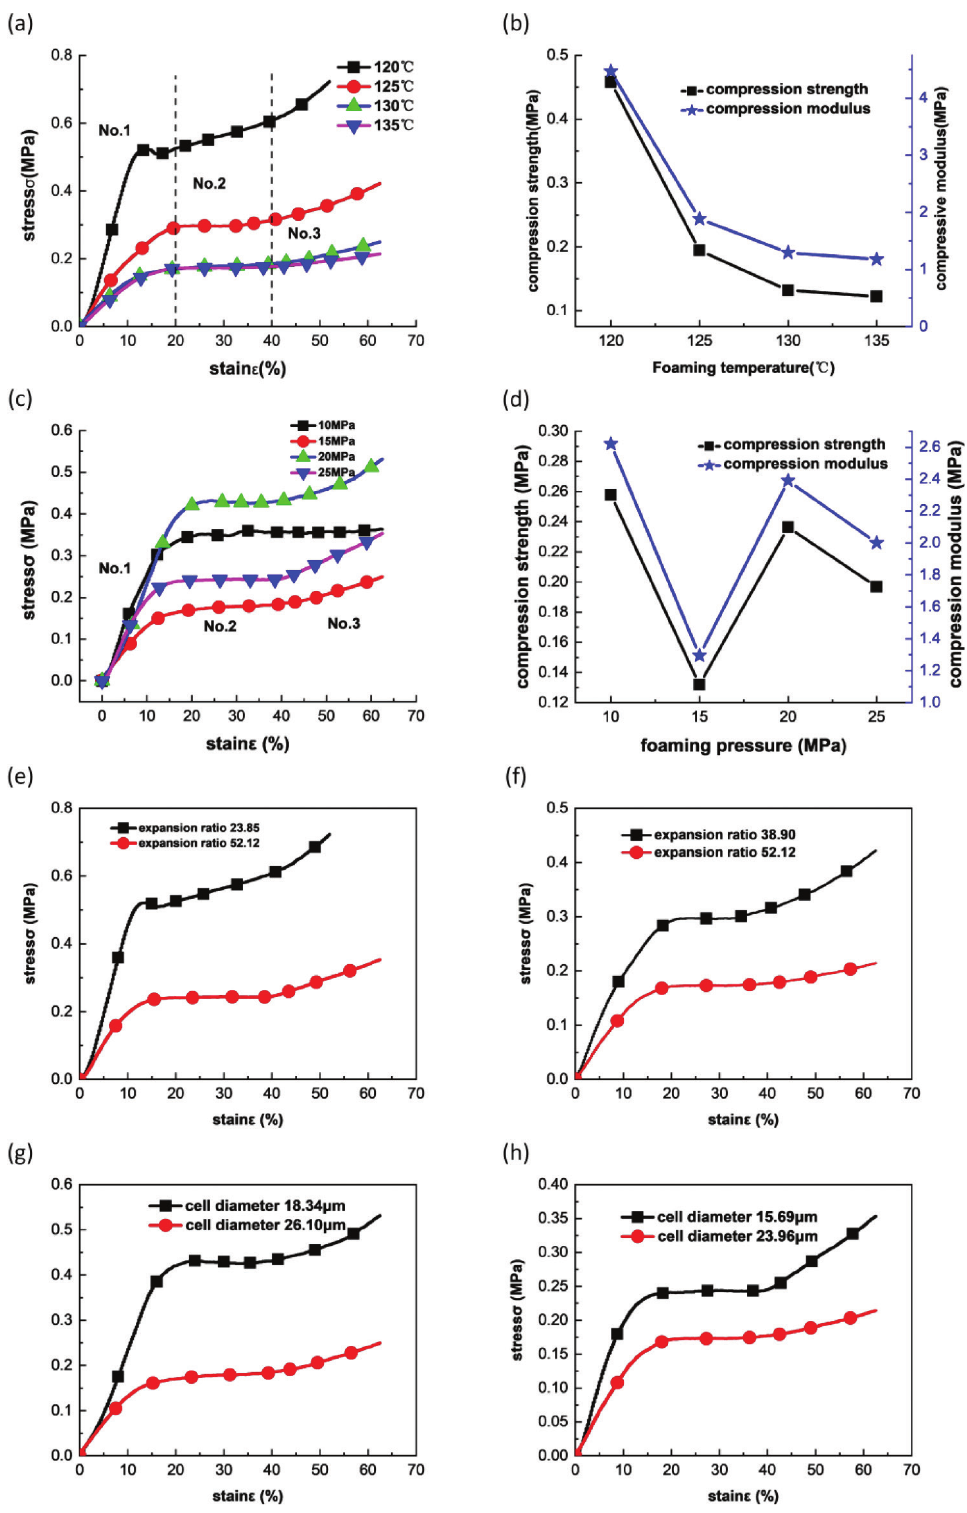
Figure 1: Effect of the microstructure on the properties of polystyrene microporous foaming material: (a) compression stress-strain curves of the samples at different foaming temperatures; (b) effects of the foaming temperature on the compression strength and modulus of the PS-MCF materials; (c) compression stress-strain curves of the samples under different foaming pressures; (d) effects of the foaming pressure on the compression strength and compression modulus of the PS-MCF materials; (e) compression stress-strain curves of the samples 1 and 7; (f) compression stress-strain curves of the samples 2 and 4; (g) compression stress-strain curves of the samples 3 and 6; (h) compression stress-strain curves of the samples 4 and